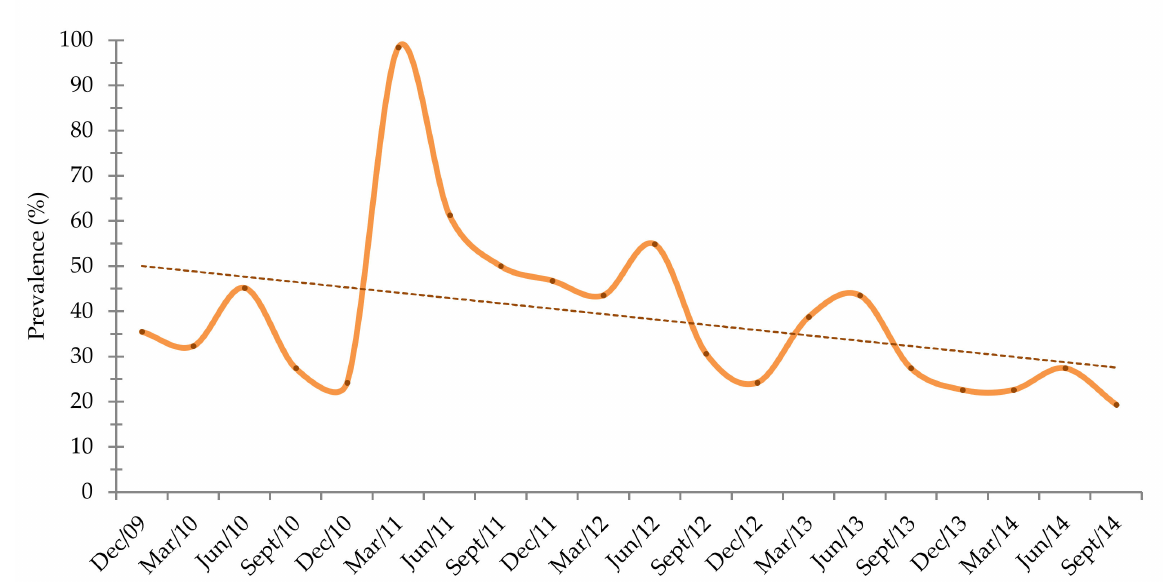
Figure 3. Parasitism prevalence from2009 to 2014 and linear trend